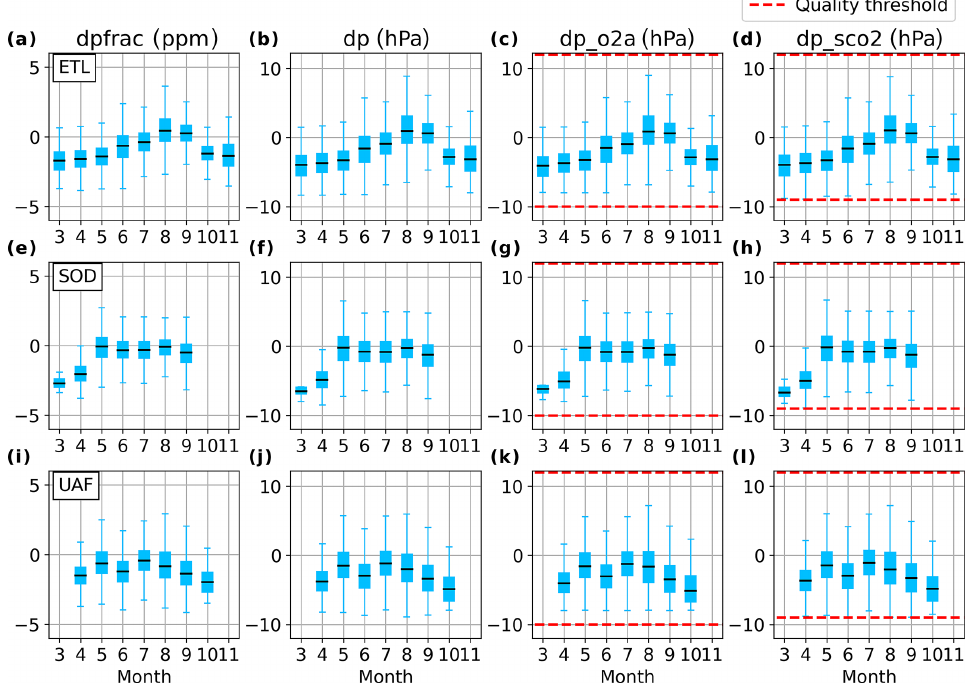
Figure 25. Seasonal box plots of dpfrac, dp, dp_o2a, and dp_sco2 at (a, b, c, and d) East Trout Lake, (e, f, g, and h) Sodankylä, and (i, j, k, and l) Fairbanks, given boreal QC